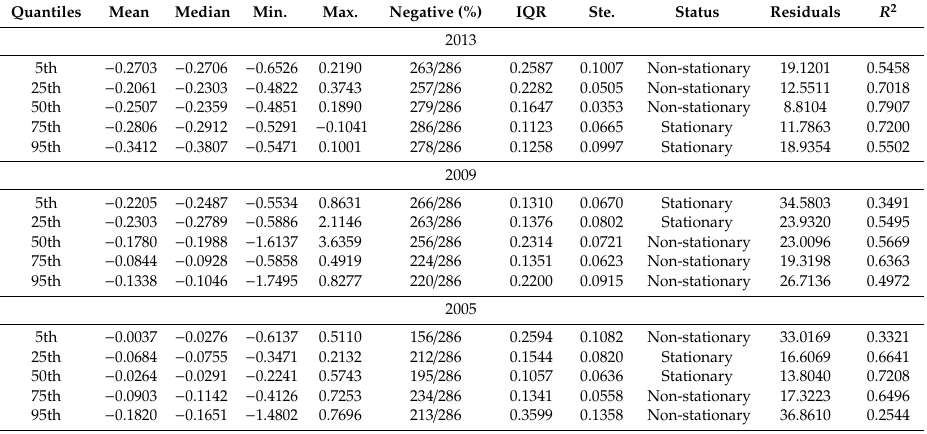
Table A1. Summary statistics of GWQR (exponential kernel function) estimate coe ffi cients of PM2.5 for 2005–2013. Quantiles Mean